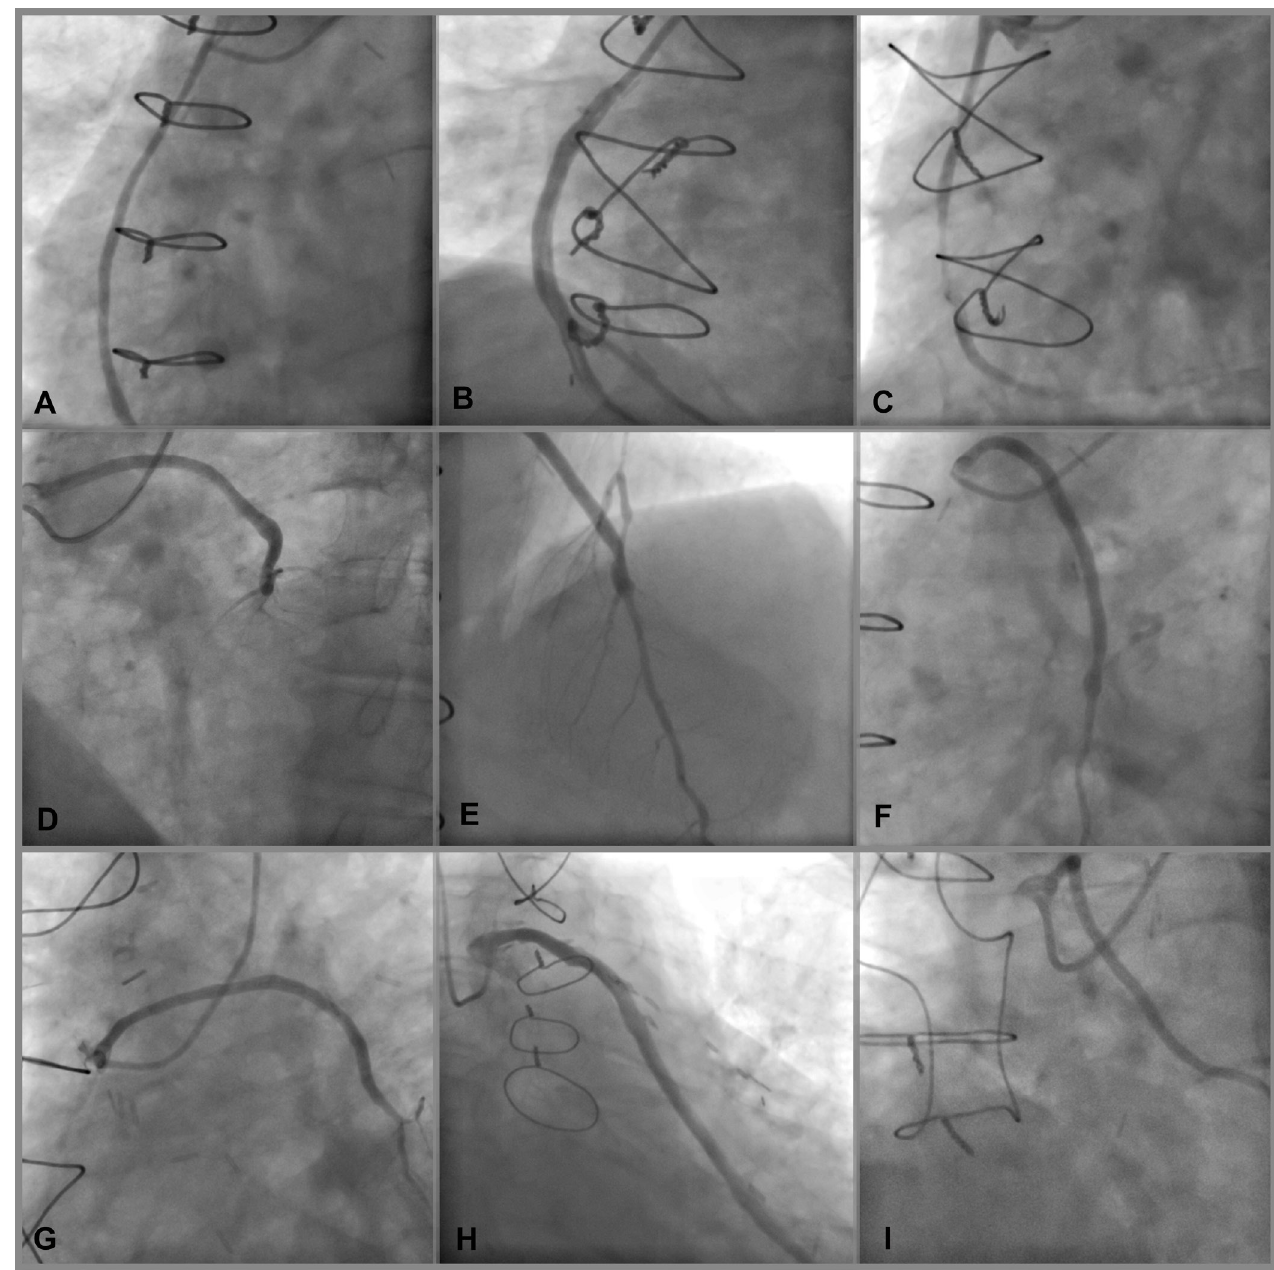
Fig. 1 – The aorta coronary bypass graft angiography with right transradial access. A, B, C = aorta-right coronary artery graft angiography. D, E, F, G = aorta-left anterior descending artery (LAD) and diagonal artery graft angiography. H, I = aorta-obtuse marginal artery graft